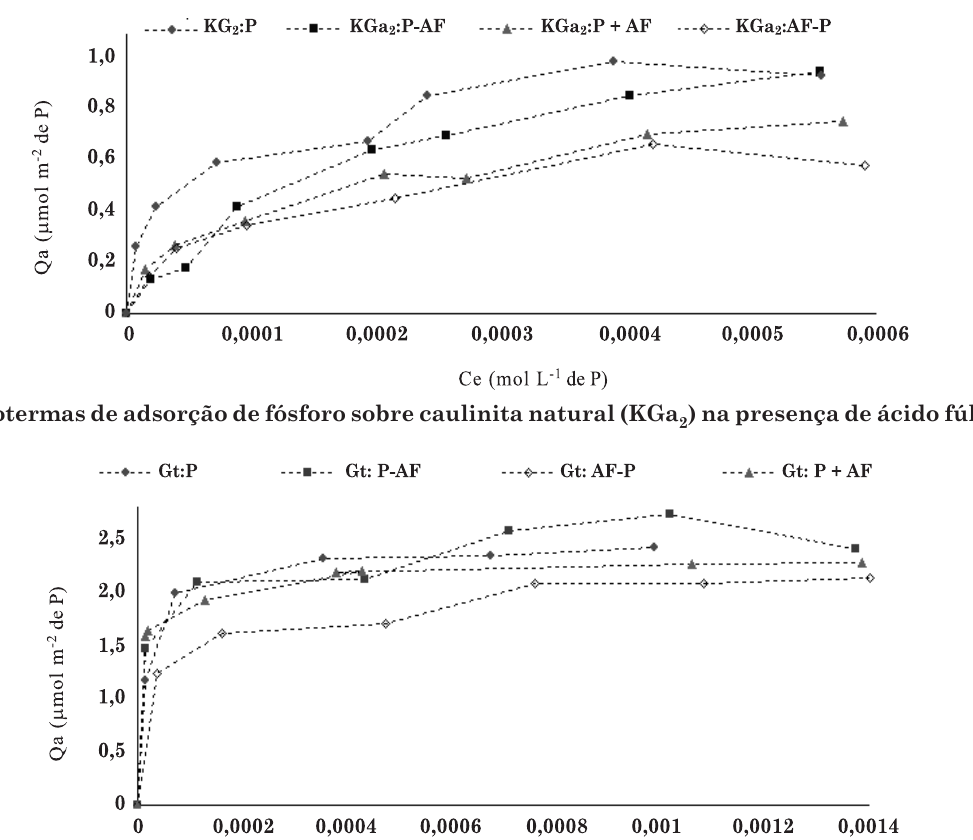
Figura 4. Isotermas de adsorção de fósforo sobre goethita sintética (Gt) na presença de ácido